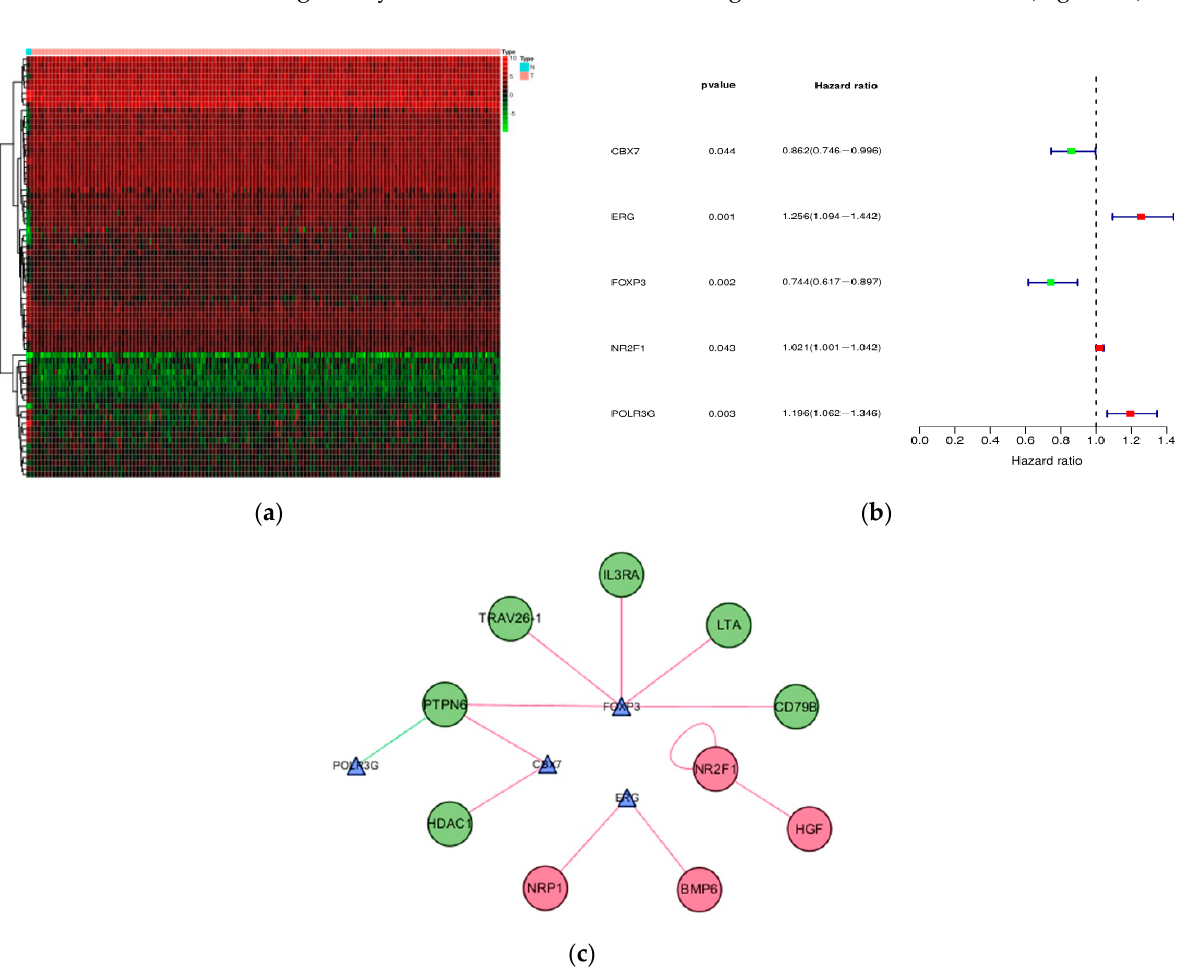
Figure 4. The clinical significance of IIRGs. The box plots showed that the expressions of TFRC, IL17RD, and HDAC1 were significantly different in subgroups of age and grade. ( a , b ) Blue represents the group of age ≤ 45years, and red represents the group of age > 45 years. ( c ) Blue represents the group of grades 1 and 2, and red represents the group of grades 3 and 4.